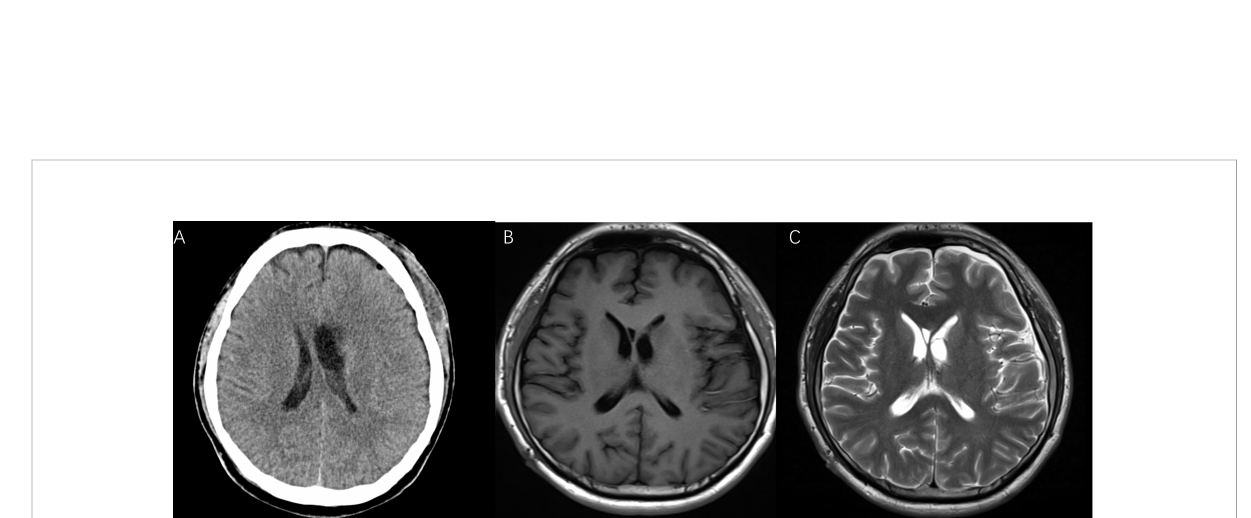
FIGURE 4 The postoperative CT (A) , T1-weighted (B) , and T2-weighted MRI (C) after one month showed good tumor resection.